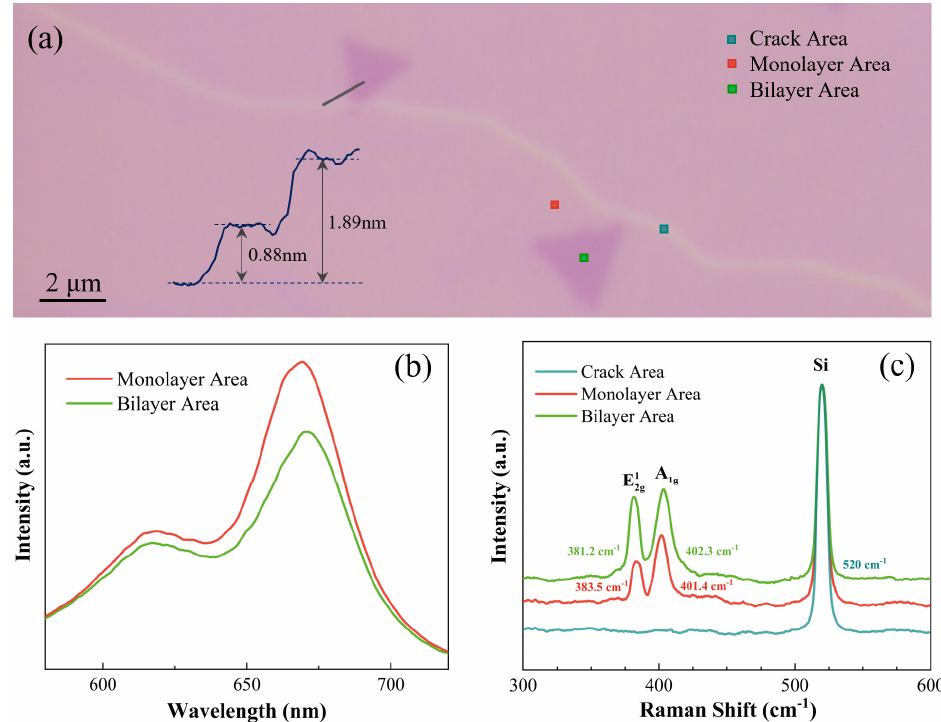
Figure 1. ( a ) Optical image of the MoS 2 sample. The inset shows the height profile, and the atomic force microscopy (AFM) profile is taken along the gray line drawn on the optical image. ( b ) Photoluminescence (PL) spectra of the monolayer and bilayer areas. ( c ) Raman spectra of the monolayer, crack and bilayer areas.